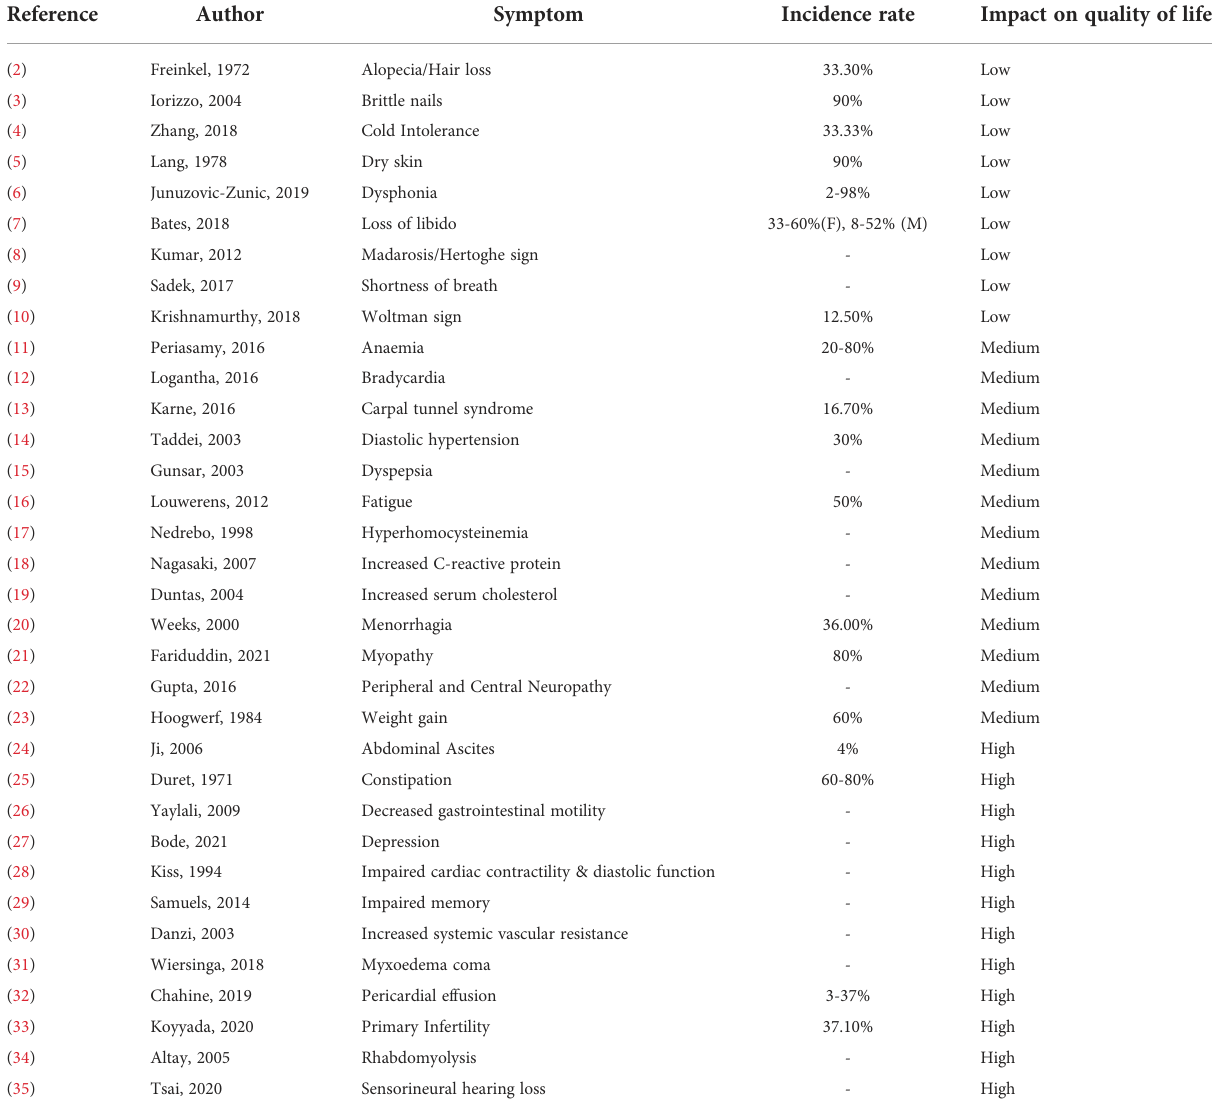
TABLE 1 Signs & Symptoms of Hypothyroidism and their impact on quality of life: This table details the signs and symptoms of hypothyroidism, along with the incidence rate and perceived impact on the quality of life of patients.